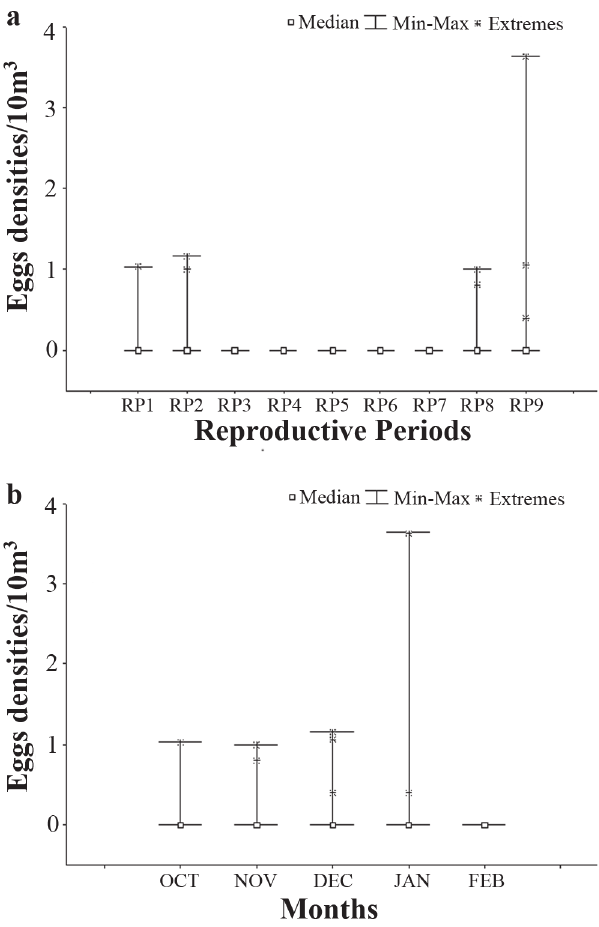
Fig 3. Density of eggs (transformed by 4 density egg ) captured in the Uruguay and Ligeiro Rivers from October 2001 to February 2010: ( a ) during different reproductive periods (RP); ( b ) in different